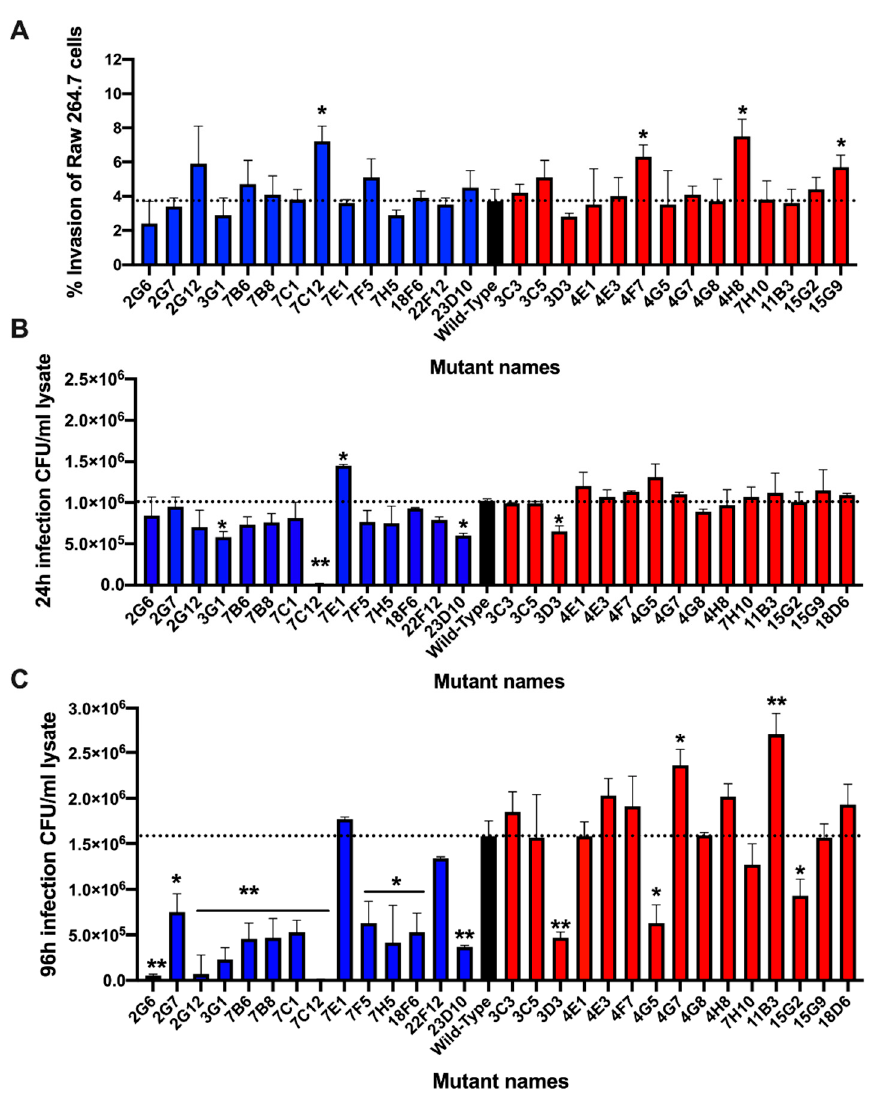
Figure 6. Verification of MAP mutants in Raw 264.7 macrophages. In order to validate if there was an association of amoeba metabolic variation with virulence mechanism of MAP, sequenced mutants were examined in Raw 264.7 macrophages for survival phenotype. Approximately, 10 6 cells seeded in 24-well plates were infected with MAP or transposons mutants at MOI of 10 for 2 h. The extracellular bacteria were removed by washing steps and treating macrophages with 200 µ g / mL amikacin. The intracellular bacteria were quantified at 2 h (baseline), 24 h and 96 h time points by plating serially diluted samples on 7H10 agar plates. ( A ) The percentage of MAP uptake by macrophages at 2 h was calculated from the original inoculum; ( B ) the intracellular bacterial growth at 24 h and ( C ) at 96 h are calculated from the baseline MAP that entered cells during 2 h infection. Data represent the mean ± SD of three independent experiments each completed in duplicate. *, p < 0.05 and **, p < 0.01 between the wild-type MAP and mutant infections at the corresponding time point.